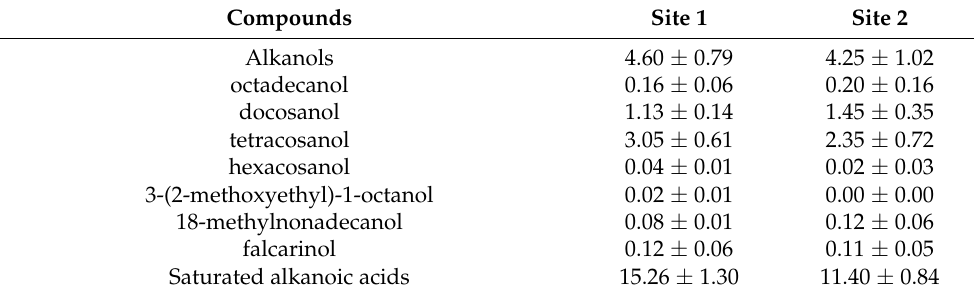
Table 6. Suberin composition from Quercus rotundifolia bark sampled at b.h. from trees grown at two sites, in % of the normalized peak areas in TIC (mean of five trees and standard